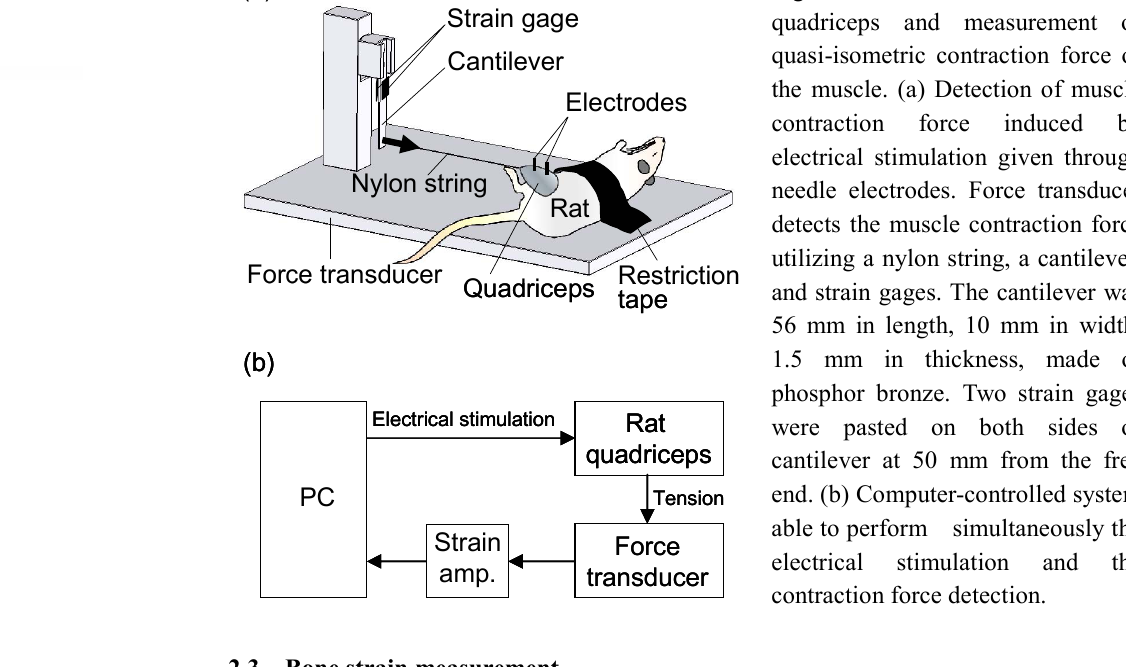
Five SD rats (12-week old, female, body weight: 231-254 g) were used for the experiments. A left thigh was dissected, and the anterior periosteal surface of the femur was exposed under the anesthesia. A single element type strain gauge (gauge length: 0.2 mm,